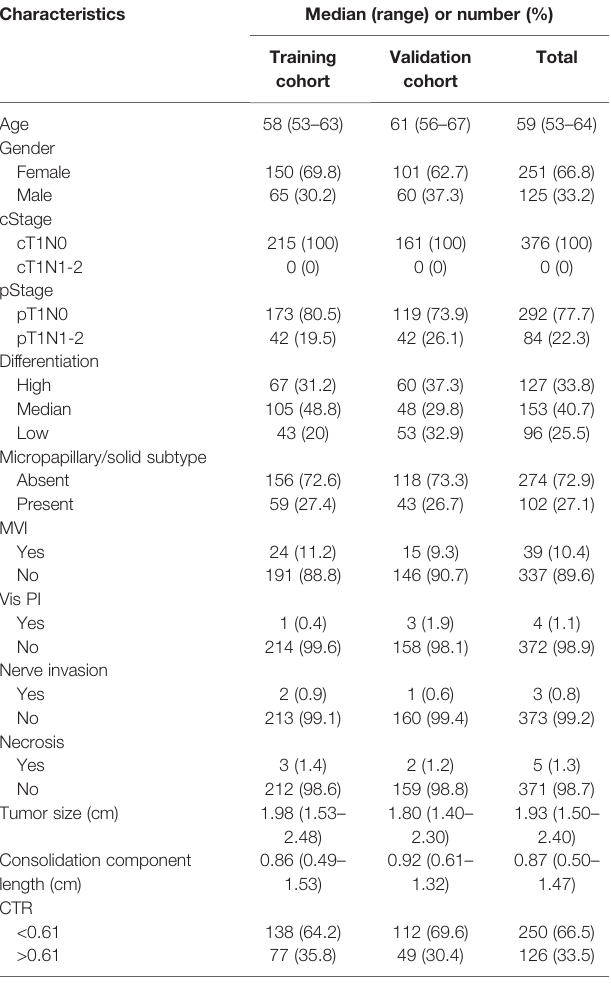
TABLE 1 | Clinical and pathological characteristics of patients.